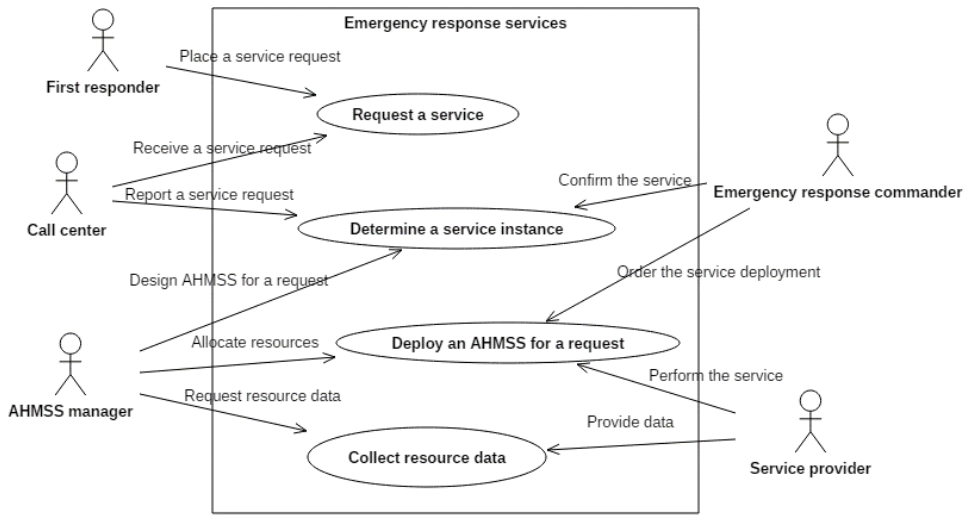
Figure 1. A use-case diagram for an AHMSS in an emergency response situation, reproduced from [6]. The design of an AHMSS requires multiple activities throughout the design